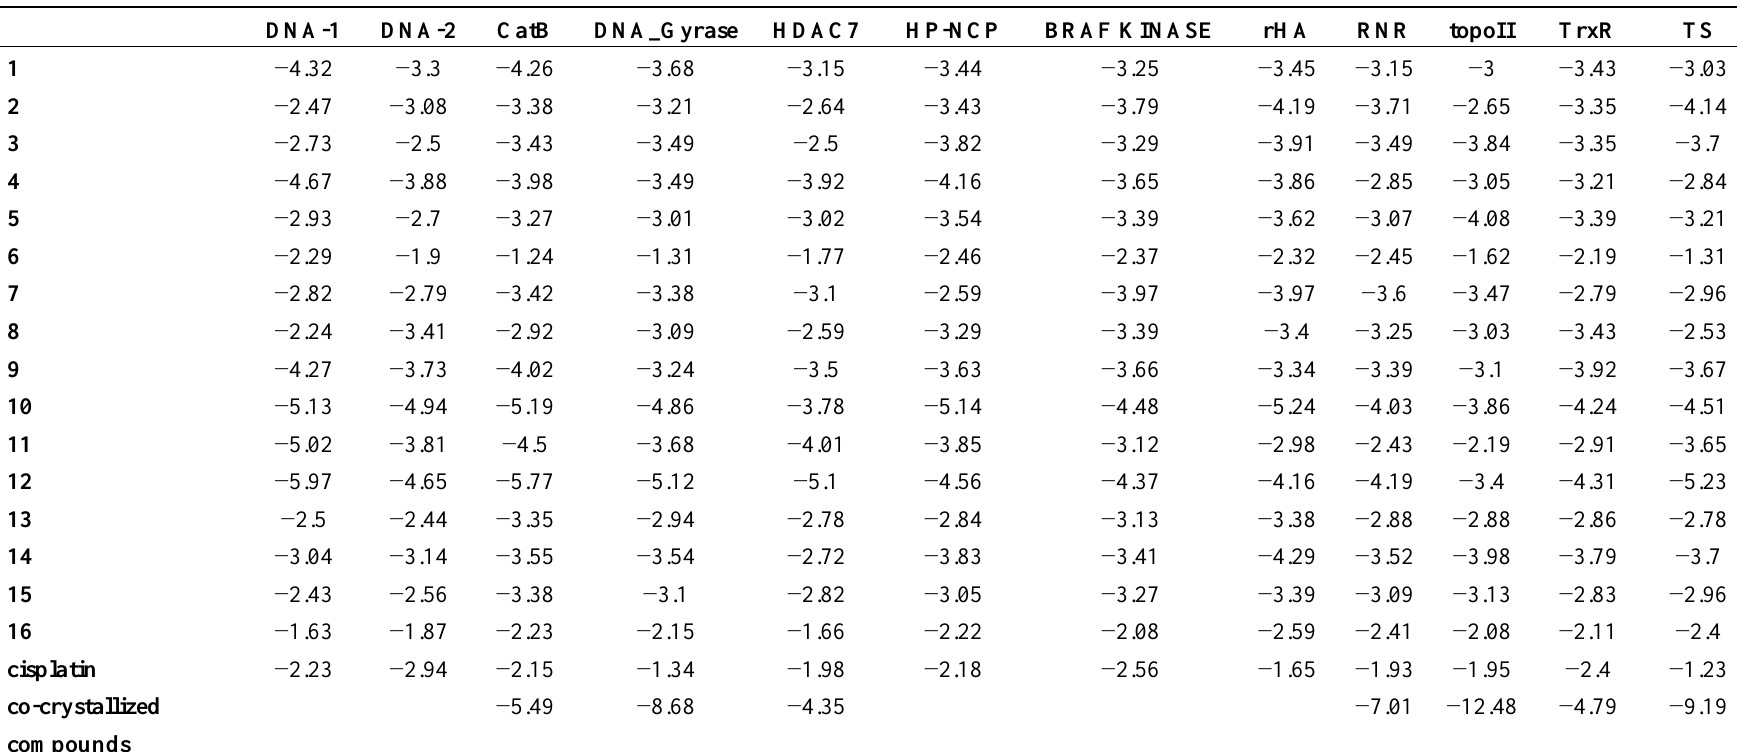
Table 2. The binding energy of the metallocompounds from the Autodock